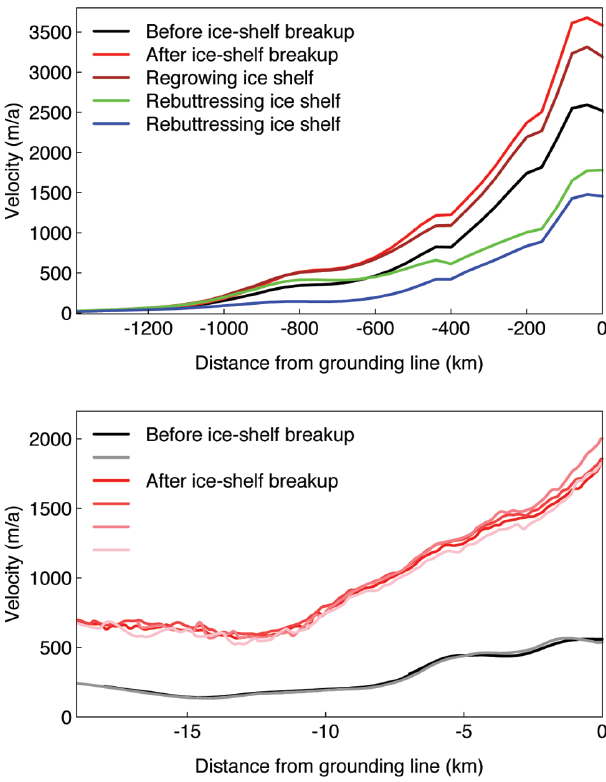
Fig. 3. Top: simulated along-flow profiles of ice velocity. The lines are color-coded for time as in Fig. 2. Bottom: surface ice velocity of the Crane Glacier profile; derived from the satellite data published by Rott et al. (2011) and shown in their Fig. 6. The different profiles, from black to light pink, correspond to December 1995, December 1999, October 2008, November 2008, April 2009 and November